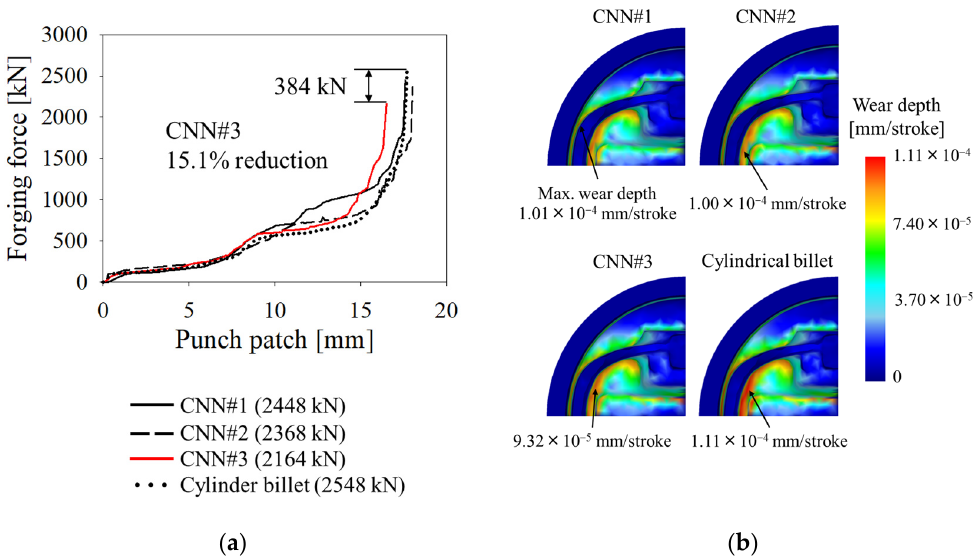
Figure 19. ( a ) Forging force–punch patch curves and ( b ) die wear distribution for CNN#1, CNN#2, CNN#3, and cylindrical billet preforms, respectively.